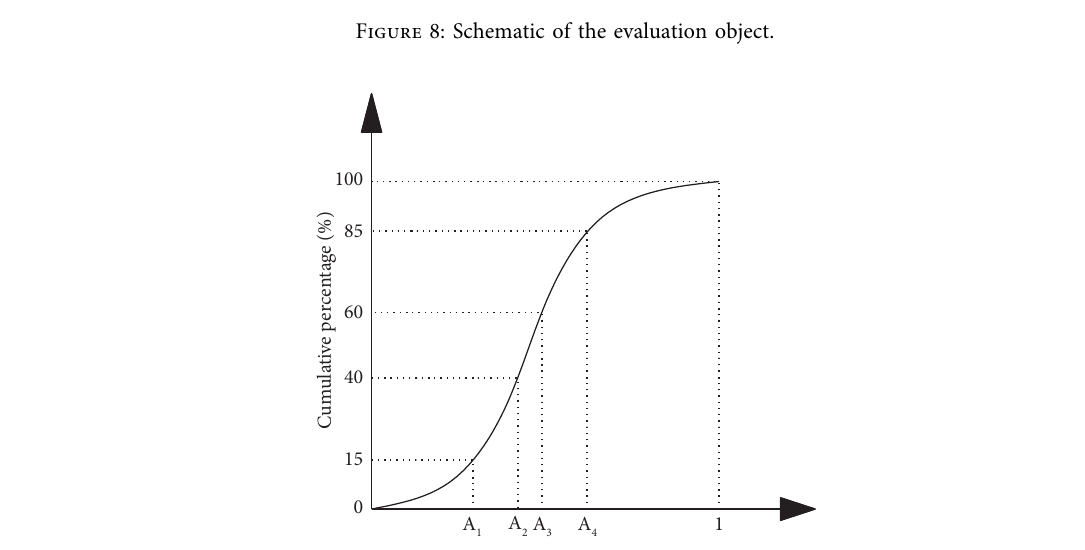
Figure 9: Cumulative frequency